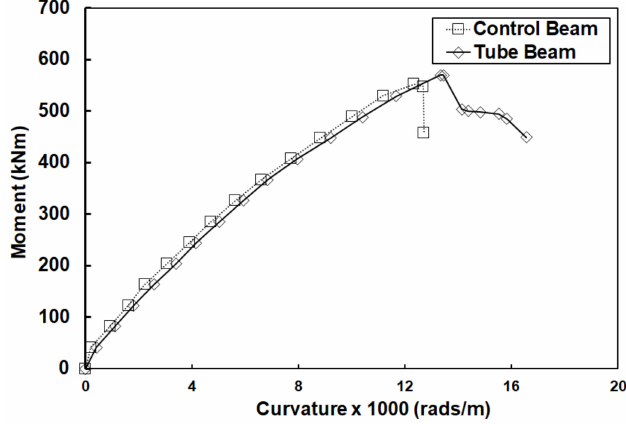
Figure 18. Experimental moment-curvature curves at mid-span for both control and tube beams. Values of curvature were calculated based on the second derivative of the deflection equations (as shown in Figure 17) at various loads.